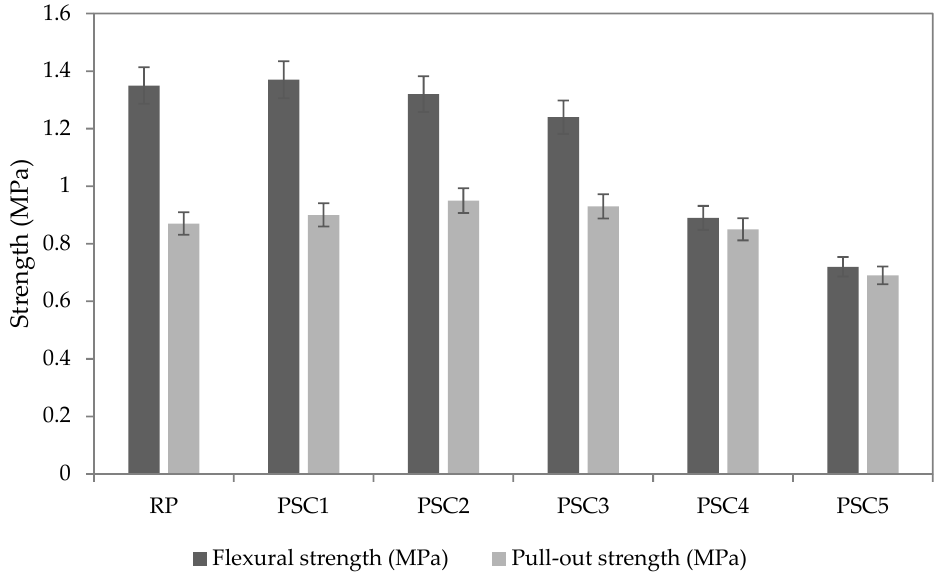
Figure 4. Mechanical performance of studied plasters. Table 3. Phase change interval and latent heat of studied plasters.